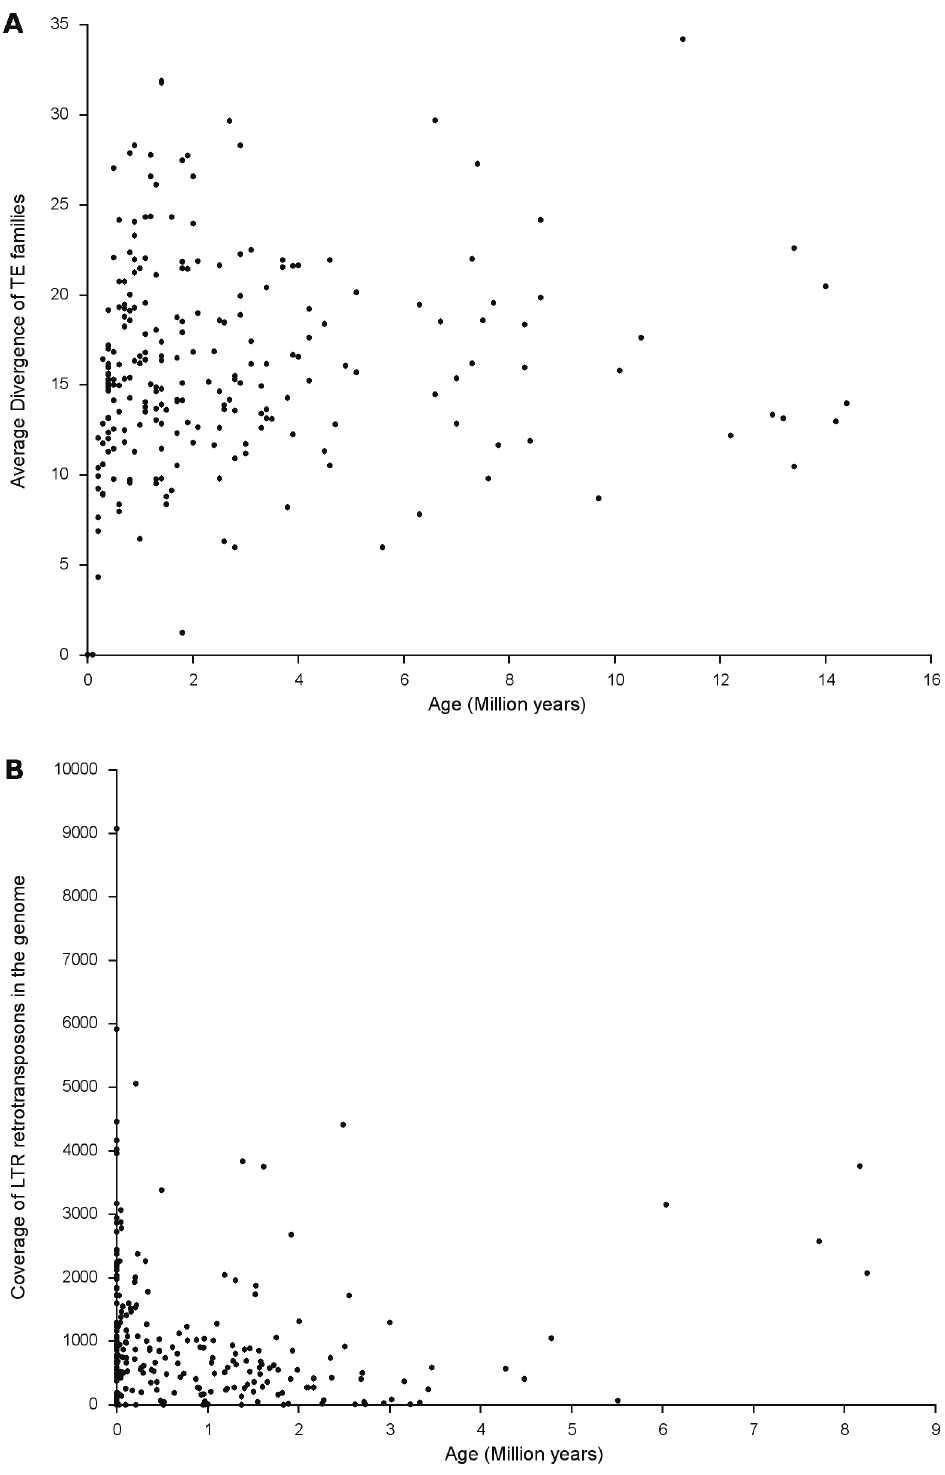
Figure 2. ( a ) The average divergence of Transposable Element (TE) families. The age of the TE families was estimated using the TE consensus approach [62 – 64] using the formula T = kr, where r = 2.0 × 10 −8 [37] ( b ) Amplification of LTR-retrotransposons in the sunflower genome as a function of its age. Insertion time estimates of Class I LTR-RTs were calculated using the formula T = d/2r, where d is the likelihood divergence estimate for each LTR-RT estimated using the Kimura 2-parameter method [61] and r = 2.0 × 10 −8